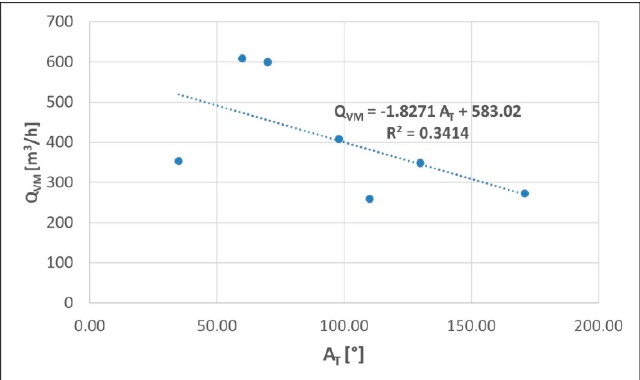
Figure 7. Influence of the slew angle on productivity.